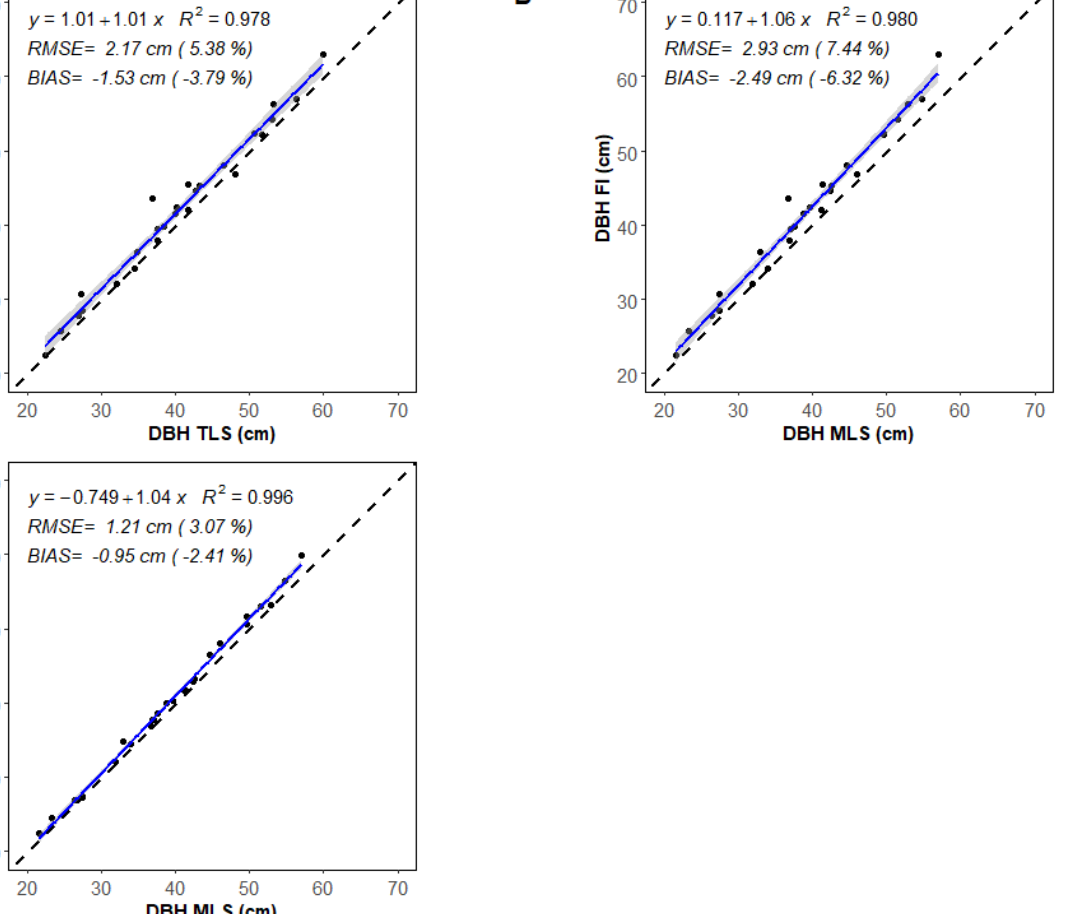
Figure 8. Comparison of diameter at breast height (DBH) between ( A ) field inventory (FI) and TLS, ( B ) FI and MLS, and ( C ) TLS and MLS for the 26 sample trees. The blue line represents the linear regression. The grey zone is the 95% confidence band for predictions. The dashed black line represents the 1:1 line.